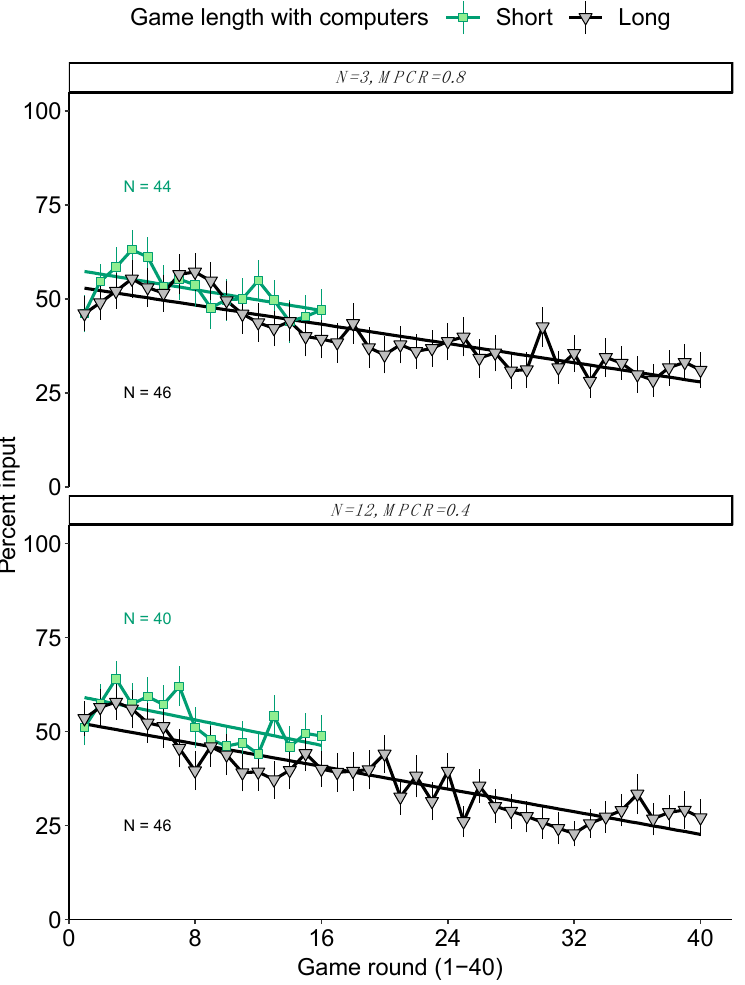
Figure 4. Learning and game length. The green data are the same as in Figure 2. Data show mean contributions with 95% confidence intervals, depending on game length, for two different black box parameter settings. The rate of learning was broadly similar in both black boxes regardless of game length, but because learning is slow in these parameter settings (large groups or high MPCR), the learning is only evident in long games. The linear regressions do not account for random effects/repeated measures and are therefore for illustration purposes only. The figures are annotated with the number of independent replicates (individuals grouped with computers). Table 4. The effect of game length. Analysis of how inputs change during the game for each black box depending on game length (16 or 40 rounds). Generalised linear mixed model with a binomial logit link and random intercepts and slopes for individuals. N = 3, MPCR = 0.8 N = 12, MPCR = 0.4